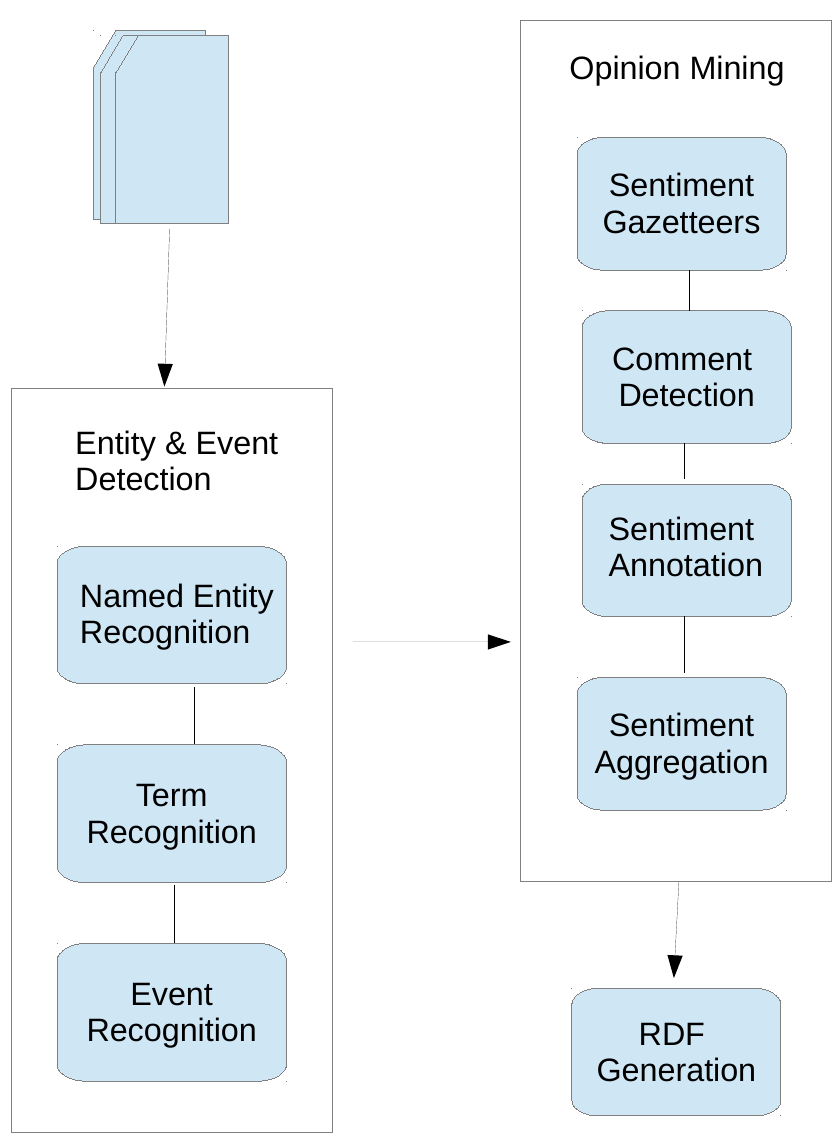
Figure 2. System